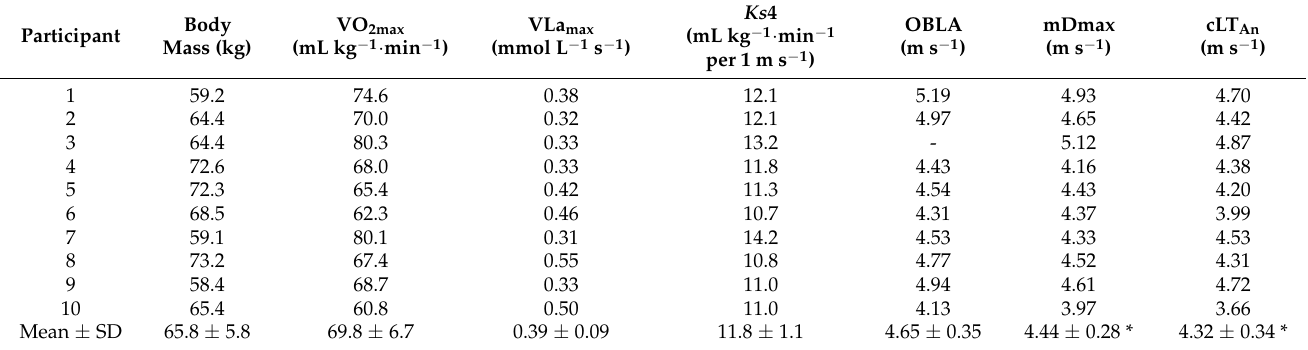
Table 1. Body mass, maximal oxygen uptake (VO 2max ), maximal lactate production rate (VLa max ), constant value of the relationship between oxygen demand and running velocity ( Ks 4), and running velocity at the onset of blood lactate accumulation (OBLA), at the modified maximal deviation method (mDmax) and the calculated anaerobic lactate threshold (cLT An ) for each